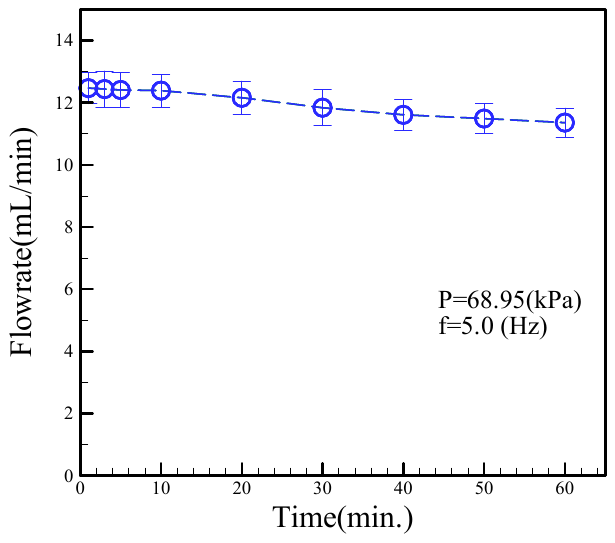
Figure 12. Valveless pumps test stability at the pressure of 68.95 kPa and frequency of 5.0 Hz. Error bars were evaluated by one sample and three tests.